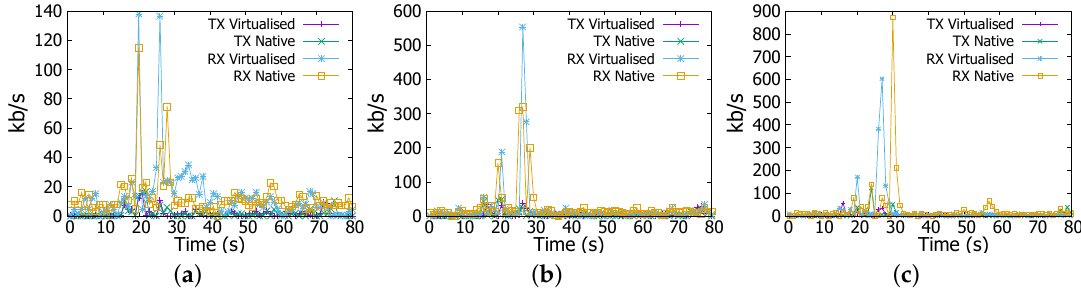
Figure 11. Transmission (TX) and reception (RX) rates in WordCount job. ( a ) 1 GB file; ( b ) 4 GB file; ( c ) 6 GB file.